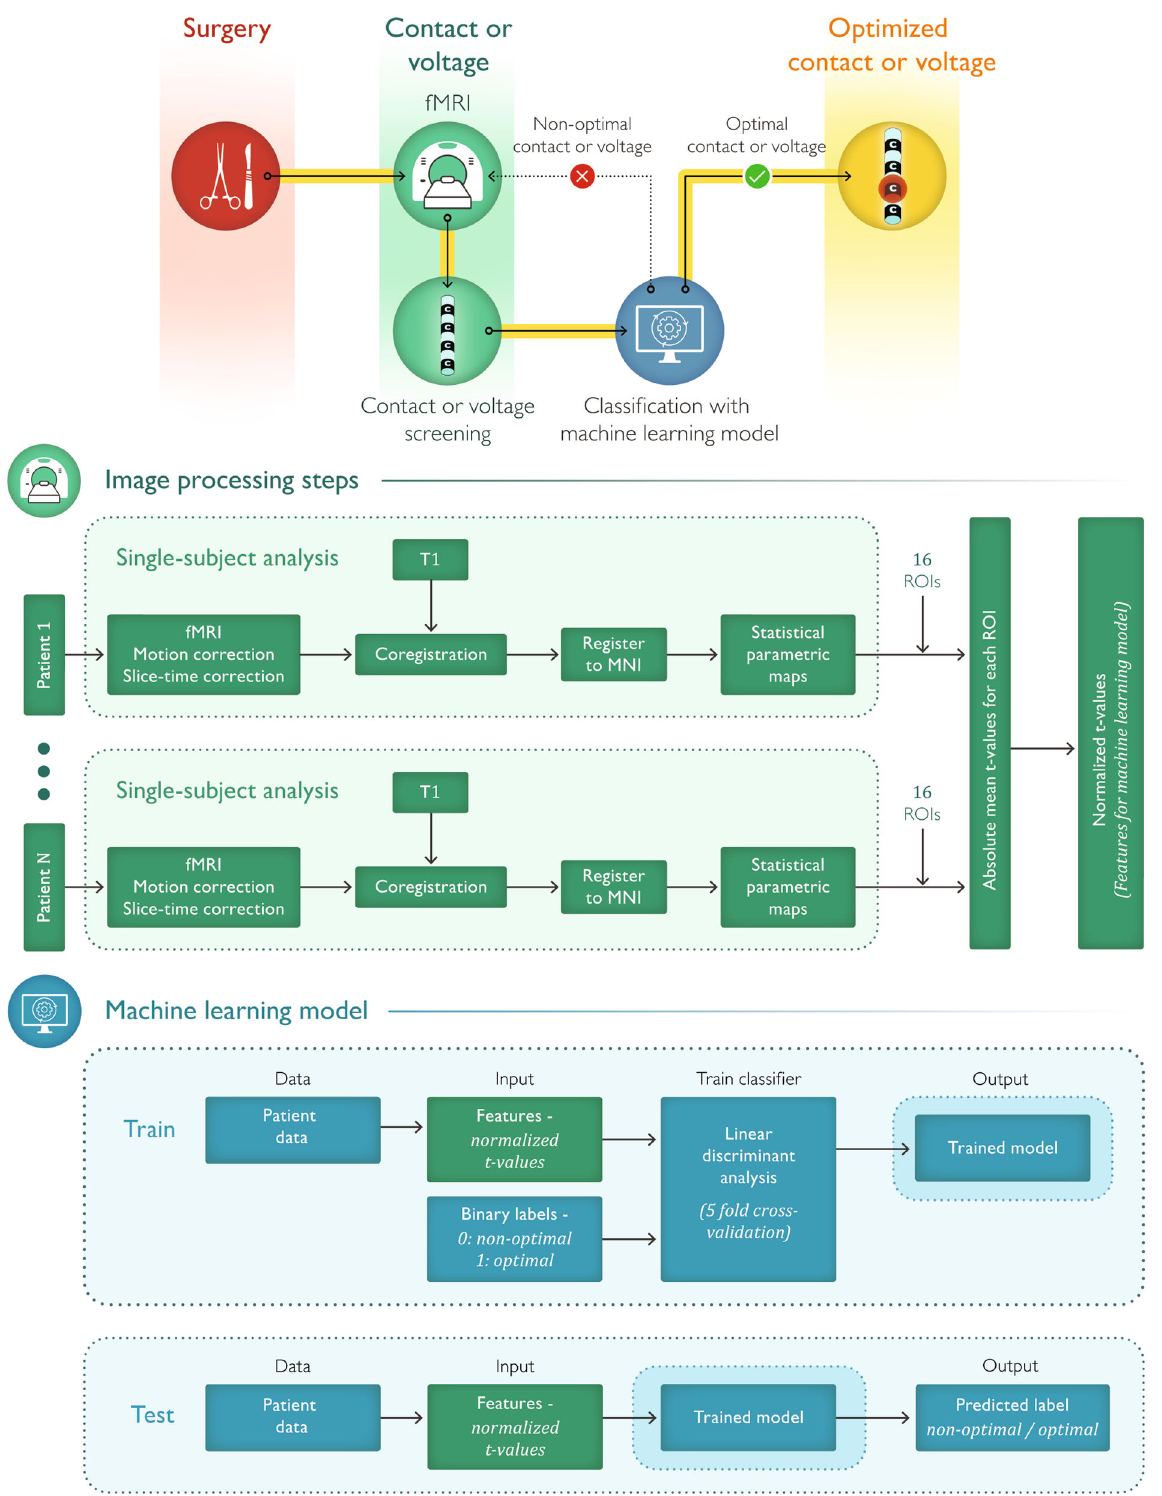
Fig. 2 Summary of the methods. (Top row) After DBS surgery, PD patients undergo fMRI with fully implanted and active DBS systems. Contacts or voltages are screened and their associated fMRI patterns are fed into the machine learning model, which classi fi es the pattern as optimal or non-optimal. (Middle row) Pipeline for fMRI data processing. (Bottom row) Machine learning model is built with a train dataset using linear discriminant analysis and 5- fold cross validation. Then, unseen test datasets can serve as input to the model for validation. fMRI functional magnetic resonance imaging.